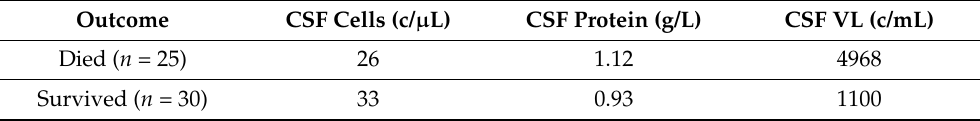
Table 2. Cerebrospinal fluid analysis (median values) by CD8E outcome. Outcome CSF Cells (c/ µ L) CSF Protein (g/L) CSF VL (c/mL) Died ( n =